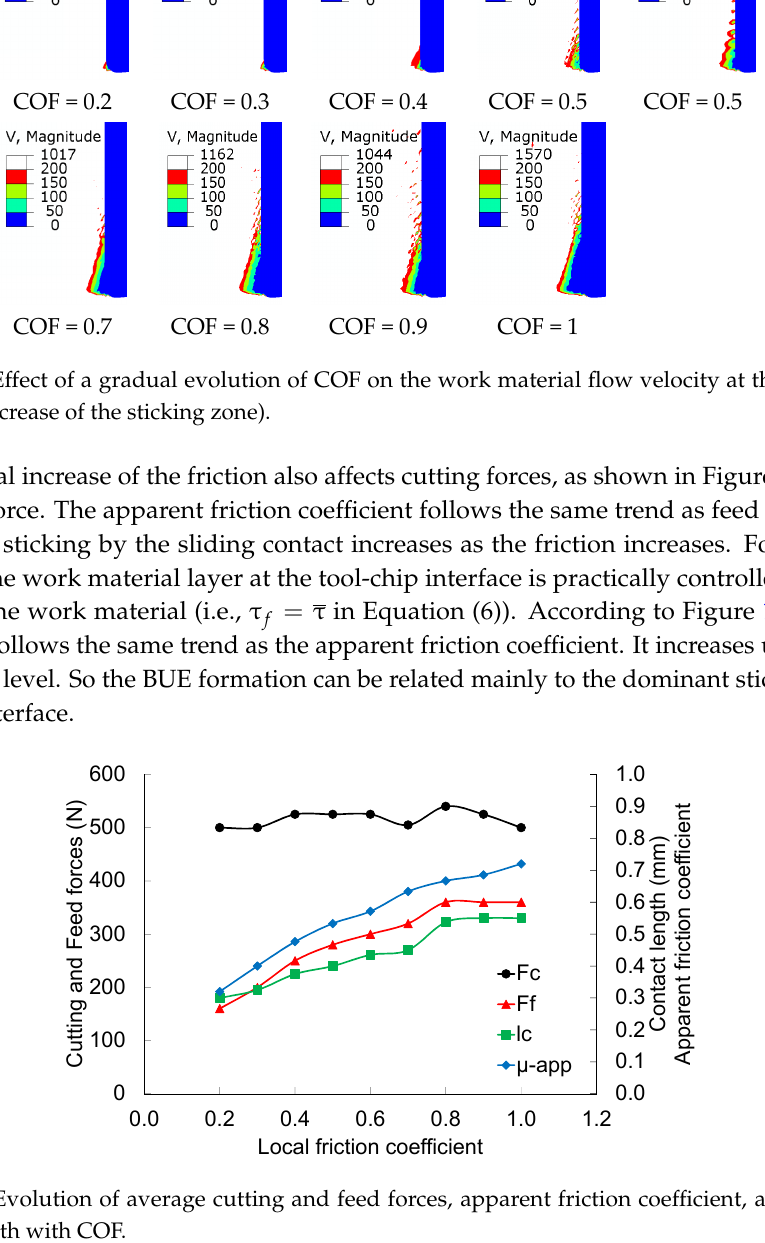
( b ) Figure 13. Effect of an abrupt change of COF on ( a ) the cutting force and ( b ) the feed force. The second possible mechanism of BUE formation corresponds to a gradual evolution of the friction at the tool ‐ work material interface during chip formation. This is represented by the increase of COF gradually (increment of 0.1 is taken) from 0.2 to 1. This assumes that BUE is formed when the